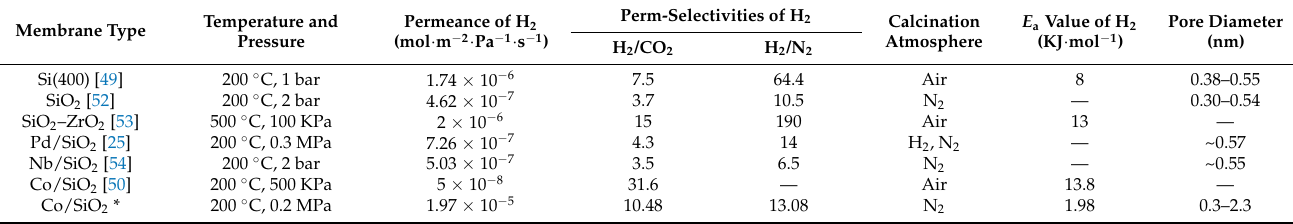
Table 3. Perm-selectivities of H 2 , permeances of H 2 , E a value of H 2 , and pore diameter for various SiO 2 membranes prepared by other researchers using sol-gel process. Membrane